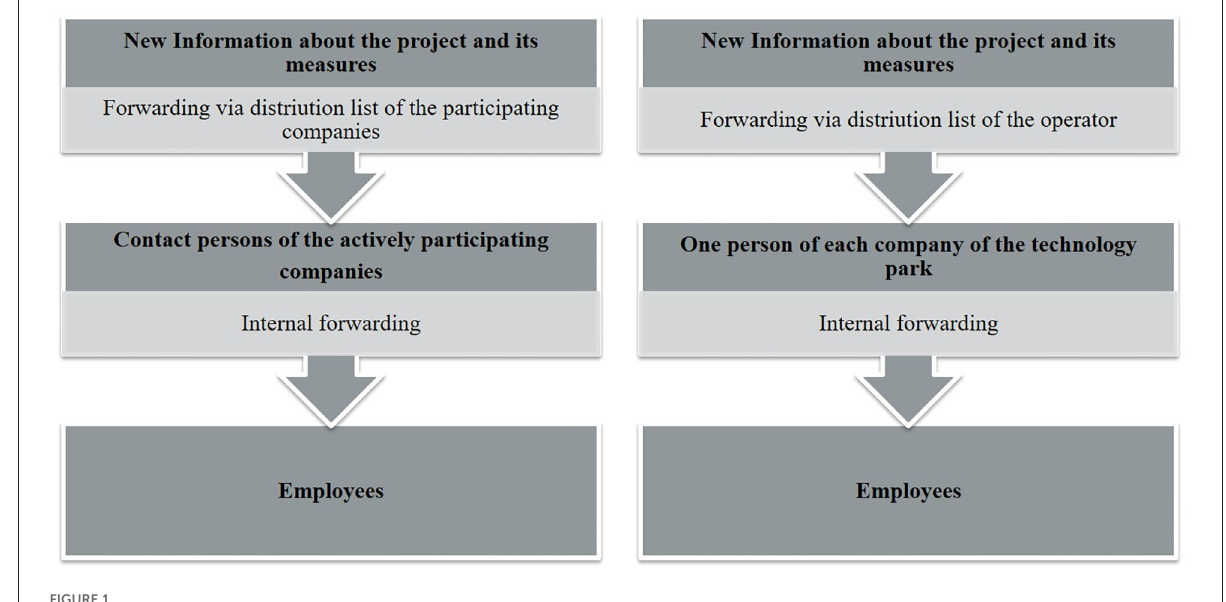
FIGURE1 Communication paths for the dissemination of